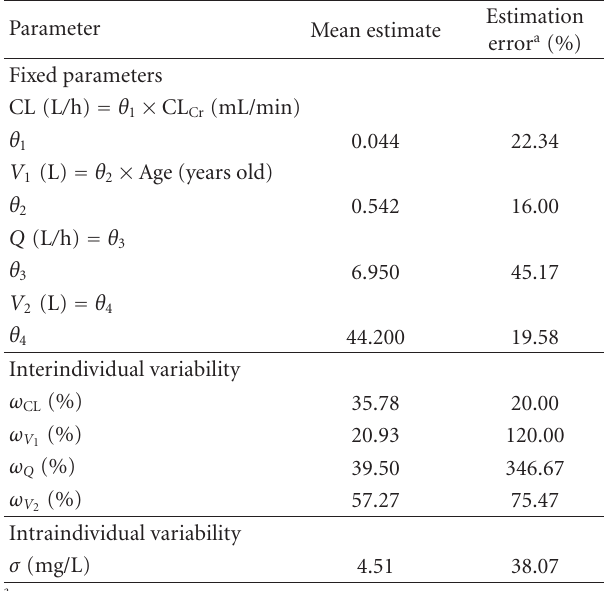
Table 2: Population pharmacokinetic parameters of vancomycin in Thai patients estimated from final model.